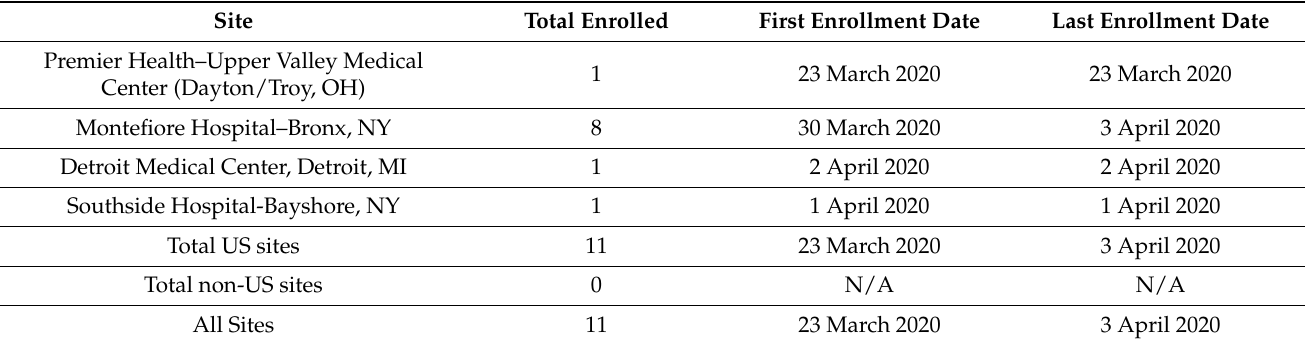
Table 2. Subject Enrollment by